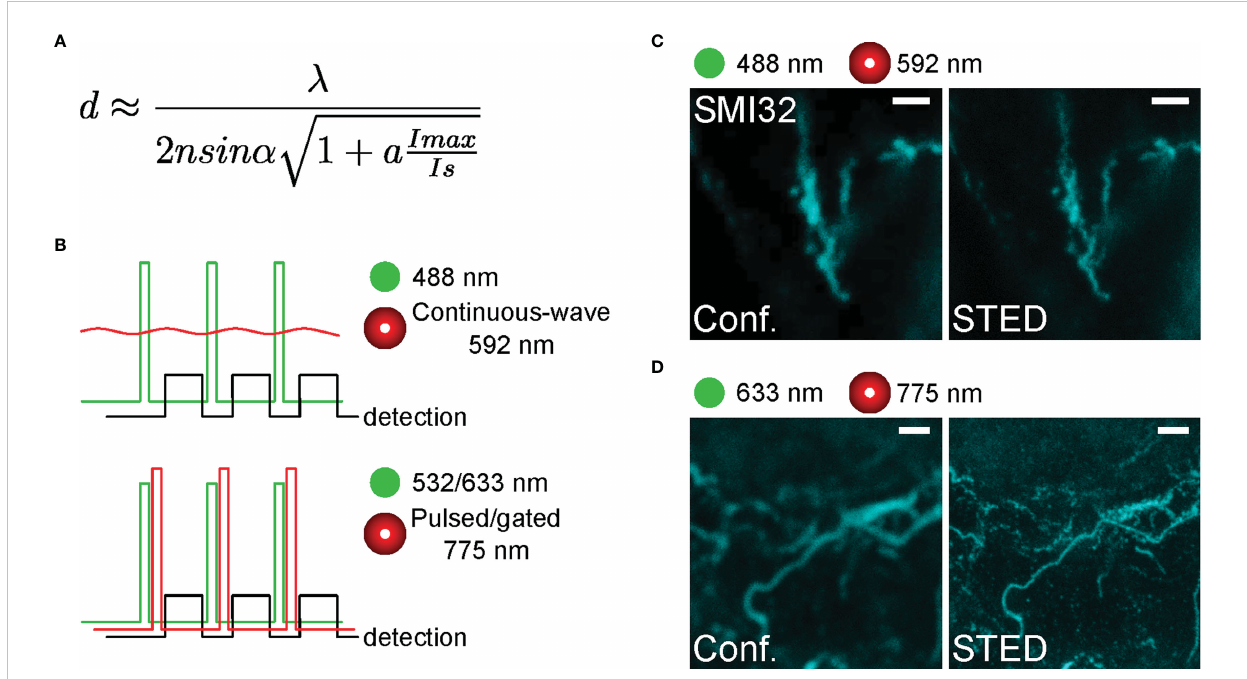
FIGURE 2 Representative SMI32-labelled structures in the inner retina acquired with different STED lasers (A) Formula for the lateral resolution of STED microscope with the saturation factor I max /I s with I max as the maximally applied laser intensity and I s as the STED laser intensity at which half of the fl uorescence is lost. (B) Temporal conditions of STED imaging. Ideally, all depleting photons act when fl uorophores are in the singlet-excited state S and fl uorescence must be registered after the stimulating photon ’ s action. Experimental time sequences are shown for the excitation (green), the depletion (red), and the emission signal detection (black) for continuous-wave STED (592 nm, top) and gated/pulsed STED (775 nm, bottom) microscopy. (C, D) Representative confocal (left) and STED (right) images acquired with different excitation and STED depletion lasers (592 nm in C, and 775 nm in D). For C, the excitation wavelength was 488 nm, and the dye was STAR488. For D, the excitation wavelength was 635 nm, and the dye was ATTO647N. Scale bars: 1